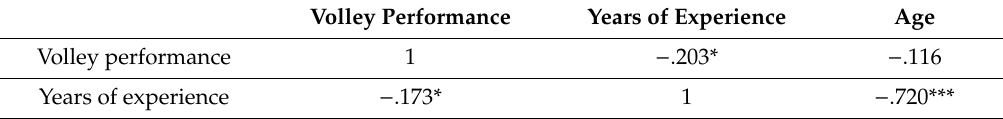
Table 2. Correlations between volley performance and years of experience controlled for